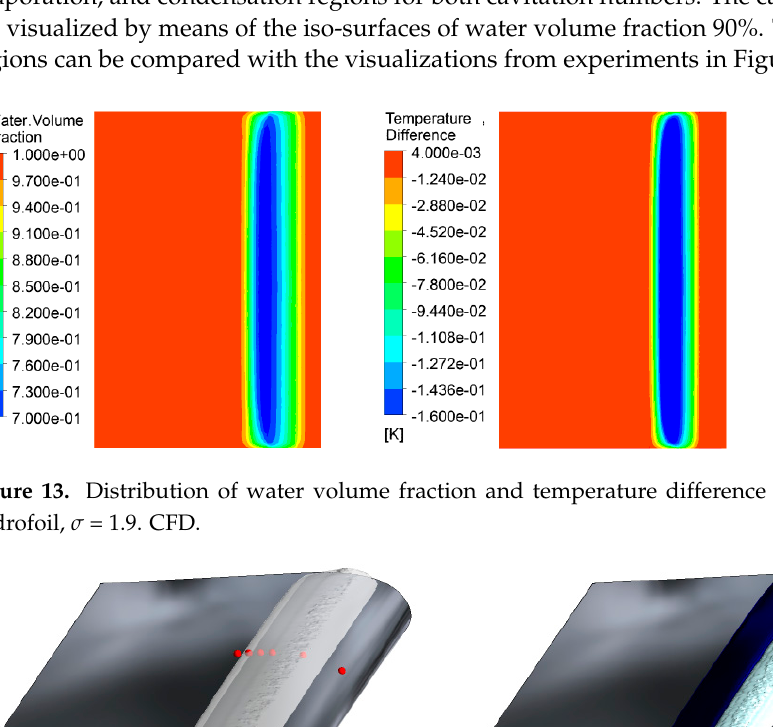
Figure 12. Comparison of numerical and experimental results on upper side of hydrofoil, σ = 1.83. ( a ) Distribution of water volume fraction; ( b ) temperature difference related to the first thermistor probe position.